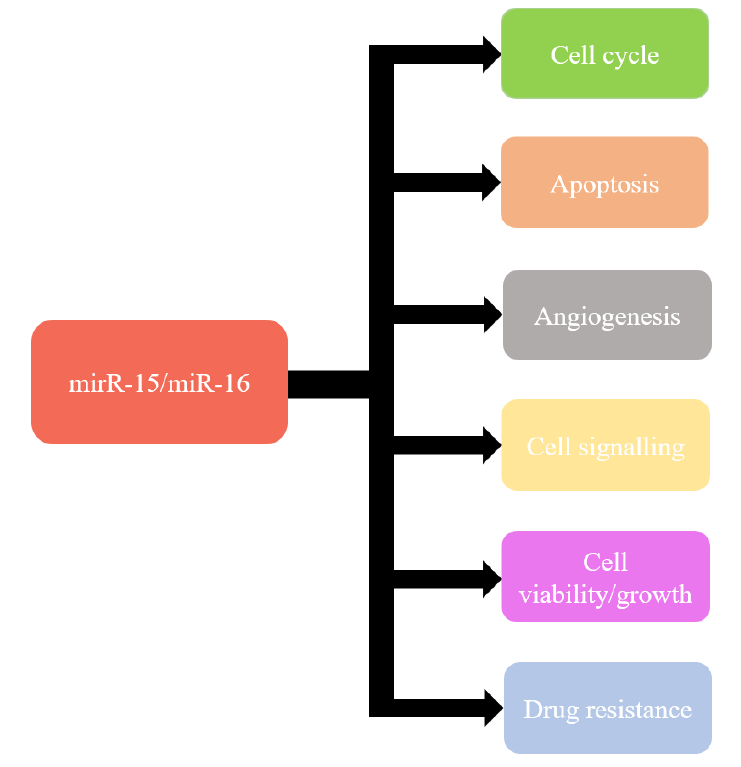
Figure 1. Functions of miR-15/miR-16.